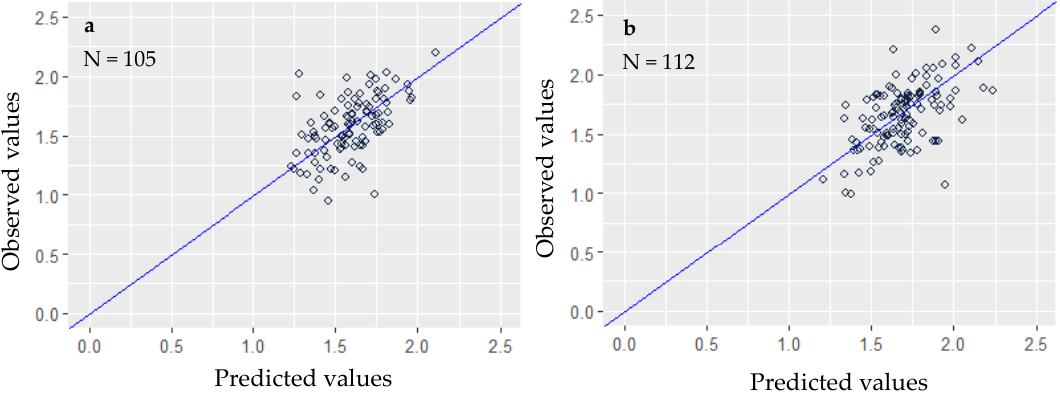
Figure 6. Observed lnL top plotted against predicted values with a line of unity for ( a ) white spruce and ( b ) balsam fir.